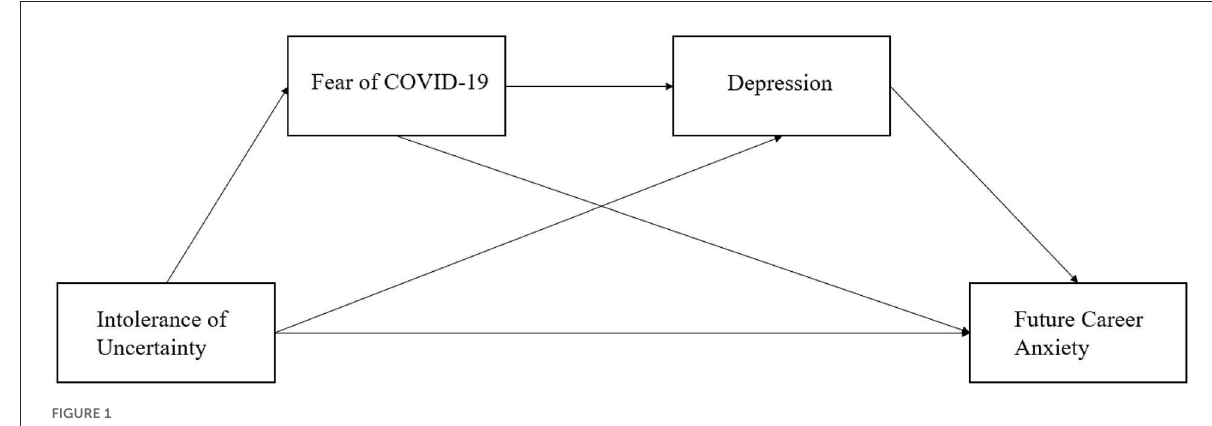
FIGURE1 Conceptual